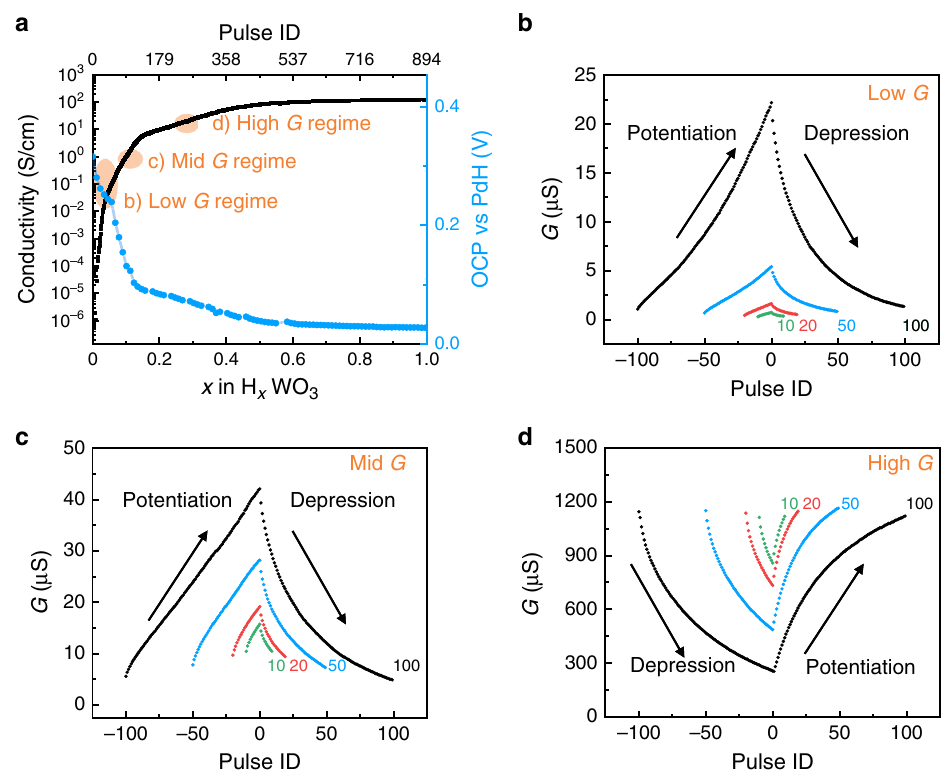
Fig. 2 Range of tunable conductivity, and electrical potentiation in different conductivity regimes. a Dependence of electronic conductivity and open circuit potential (channel WO 3 vs. gate PdH x ) on the hydrogen content in H x WO 3 . b – d Reversibility of electronic conductance, and symmetry of potentiation (protonation) – depression (deprotonation) behavior, obtained in the three different protonation regimes starting from ( b ) low conductance regime, ( c ) medium conductance regime and ( d ) high conductance regime (depression fi rst to avoid saturation). 10, 20, 50, and 100 states (upon 10, 20, 50, and 100 pulses, respectively) were obtained for each regime by constant current pulsing for potentiation and depression on the same device. Different conductance regimes were achieved by continuously sending constant current pulses with 0.5 μ A amplitude and 5 ms width until desired conductance values is